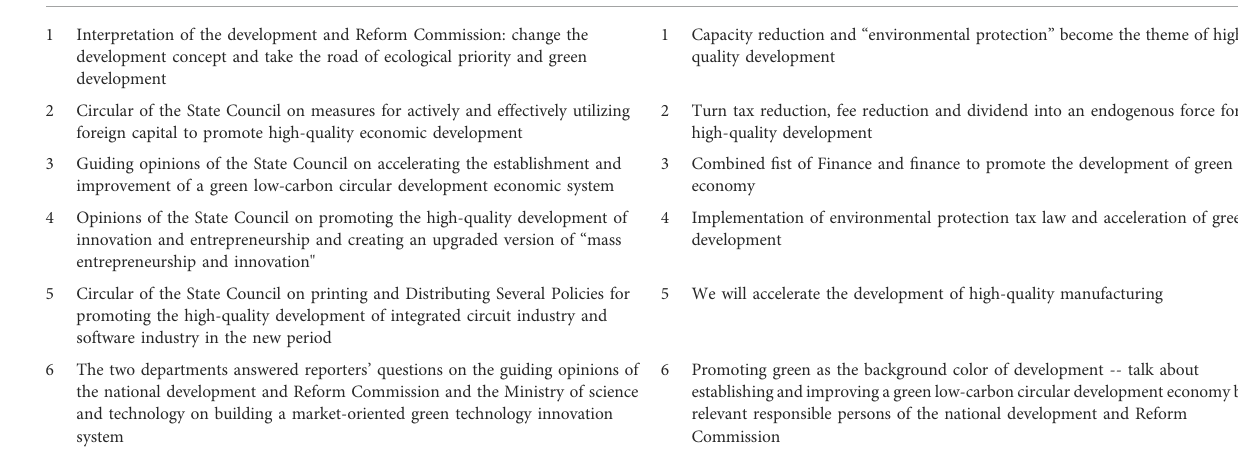
TABLE 2 Document title